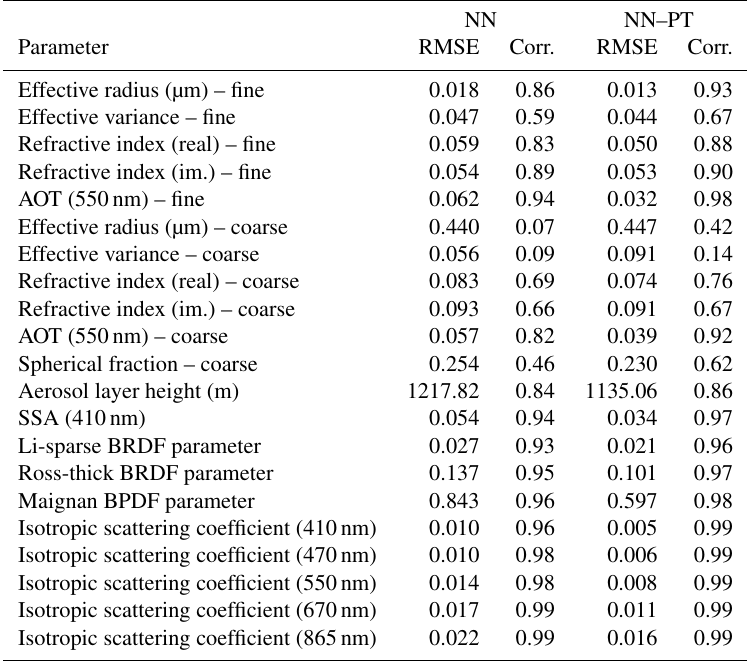
Table 3. Rms error and correlation coefficient between true and retrieved parameters for the neural network retrieval alone (NN) and for the combined NN–Phillips–Tikhonov algorithm